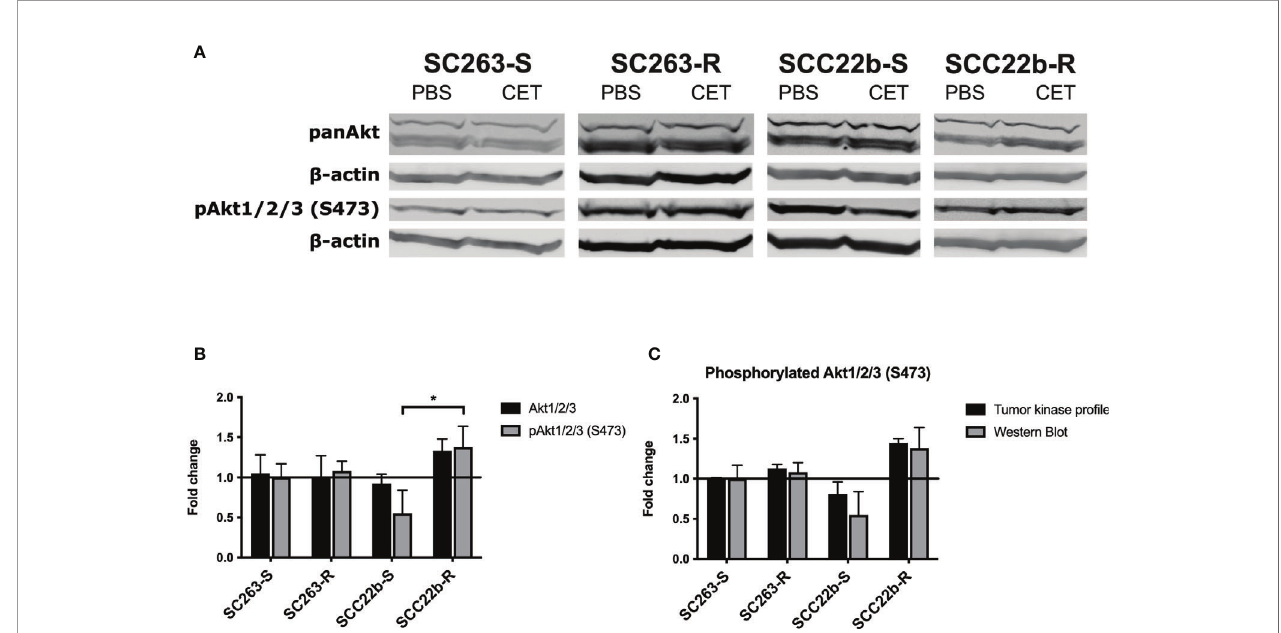
FIGURE 2 | Protein levels of total and phosphorylated Akt1/2/3 in cetuximab sensitive (SC263-S and SCC22b-S) HNSCC cell lines and corresponding acquired cetuximab resistant (SC263-R and SCC22b-R) variants. (A) Western blot was used to determine the levels of total and phosphorylated Akt1/2/3 (S473) after cetuximab treatment in cetuximab sensitive and acquired cetuximab resistant HNSCC cell lines. b -actin detection served as loading control. (B) Quanti fi cation of western blot results for total and phosphorylated Akt1/2/3. Signals were corrected for b -actin and the effect of cetuximab treatment is presented as fold change. Fold changes were calculated by dividing the mean fl uorescent signal of the treatment and control groups. The graph represents the average fold change of three independent experiments. (C) Fold change of phosphorylated Akt1/2/3 at S473 following cetuximab treatment observed with protein phosphorylation pro fi ling and western blot. CET, cetuximab; pAkt1/2/3, phosphorylated Akt1/2/3; *p-value ≤ 0.050. Suf fi x -S: cetuximab sensitive cell line and suf fi x -R: acquired cetuximab resistant cell